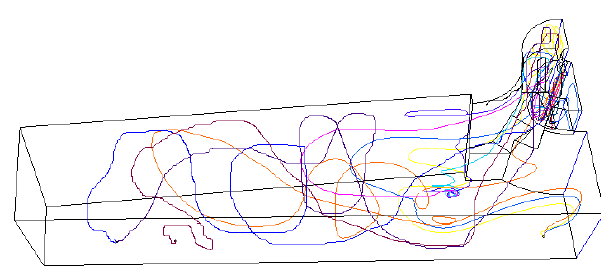
Figure 6: Temperature distribution in tundish.